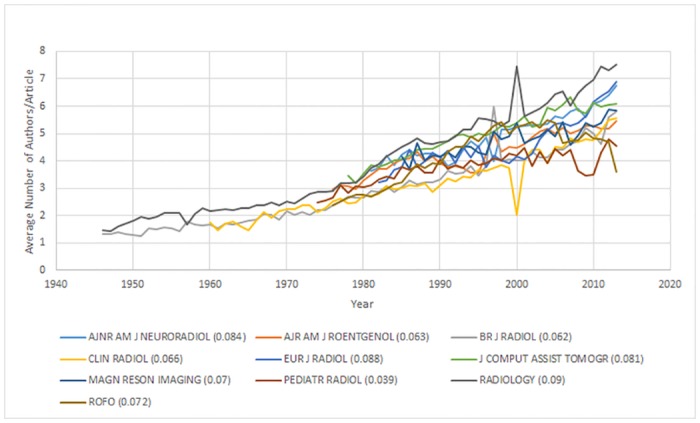
Average Number of Authors/Article per Year for Top 10 Contributing Journals.This graph shows the mean number of authors/article for the Top 10 contributing journals by # of articles published relative to the # of articles published for all radiology journals analyzed.